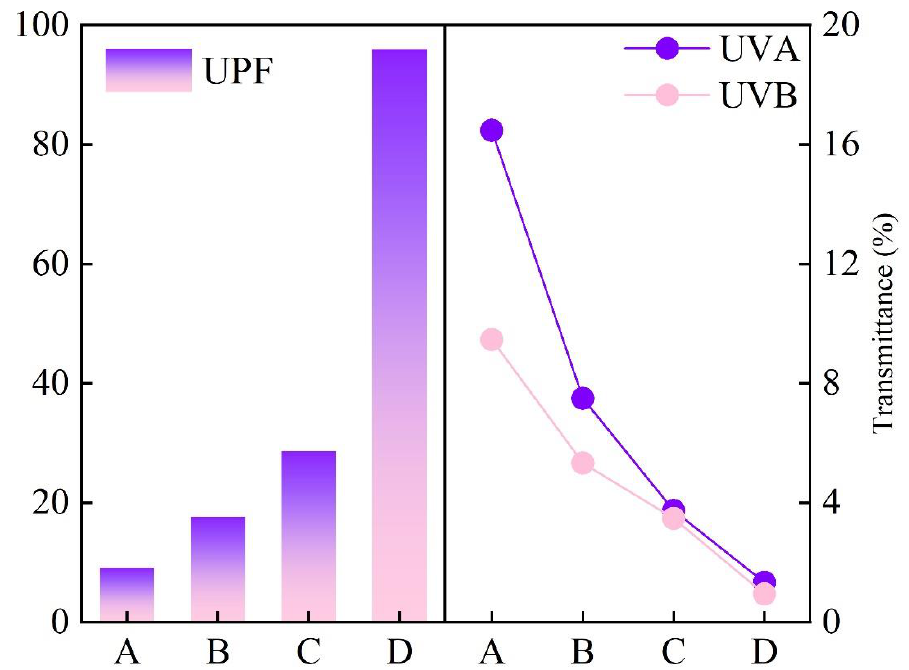
Figure 13. UV resistance of PET (A), CA-PET (B), CA-Fe-PET (C), and CA-Fe-SH-PET (D)